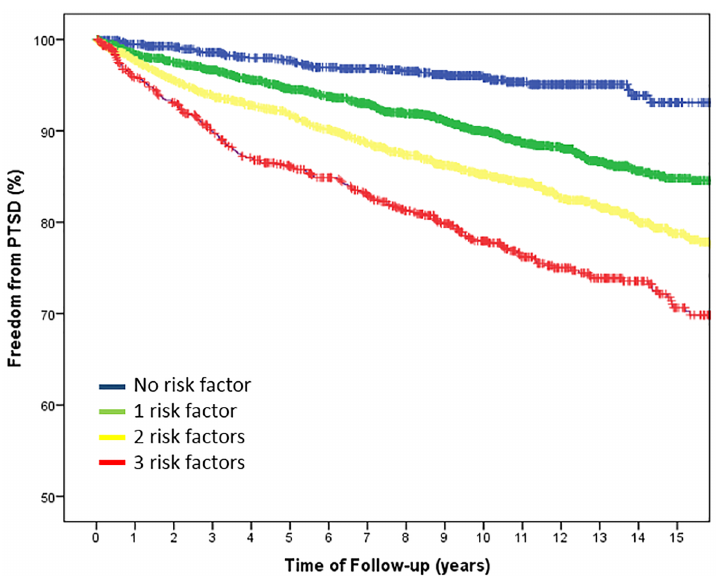
Fig 1. Kaplan-Meier charts for Freedom from PTSD stratified for the three independent risk factors smoking, chest pain and younger age.